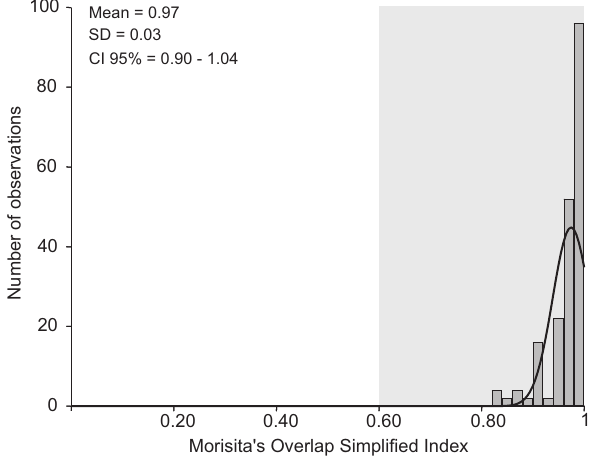
Figure 4. Results of the Bootstrap technique applied to juvenile Menticirrhus americanus and M. littoralis during the spring of 2001. The graph informs the distribution of the 200 generated indexes, with their respective means, standard deviations and 95% confi- dence intervals. The grey area indicates biologically significant overlap